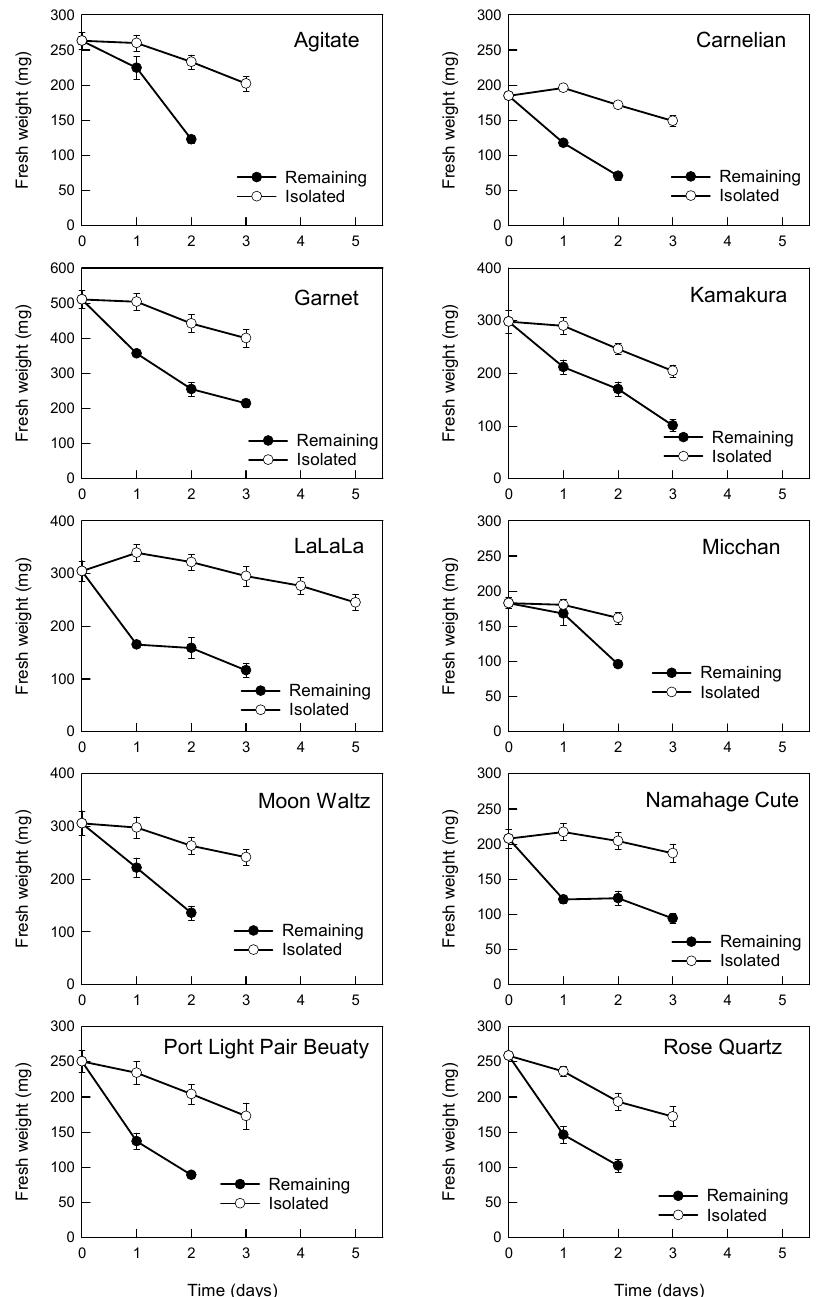
Figure 3. The fresh weight of petals isolated from inflorescence in the wilting process and those remaining in the inflorescences of 10 dahlia cultivars. Values are the means of six replicates ± SE. In contrast, the fresh weight of isolated petals in ‘Carnelian’, ‘LaLaLa’, and ‘Namahage Cute’ increased during the first day, and decreased thereafter. Additionally, the fresh weight of the isolated petals in ‘Agitate’, ‘Garnet’, ‘Kamakura’, ‘Micchan’, and ‘Moon Waltz’ was almost constant during the first day, and decreased thereafter. In ‘Port Light Pair Beauty’, and ‘Rose Quartz’, the fresh weight of petals gradually decreased with time. As shown in Figure 4, petals of ‘Agitate’, ‘Carnelian’, ‘Garnet’, ‘Kamakura’, ‘LaLaLa’, ‘Moon Waltz’, and ‘Namahage Cute’ exhibited bending due to petal wilting. The supplement of water induced recovery from wilting in these